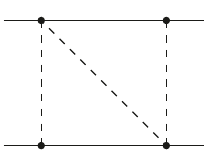
Figure 3 . The graph associated with the integral B ( s, t, m 2 ) in eq.